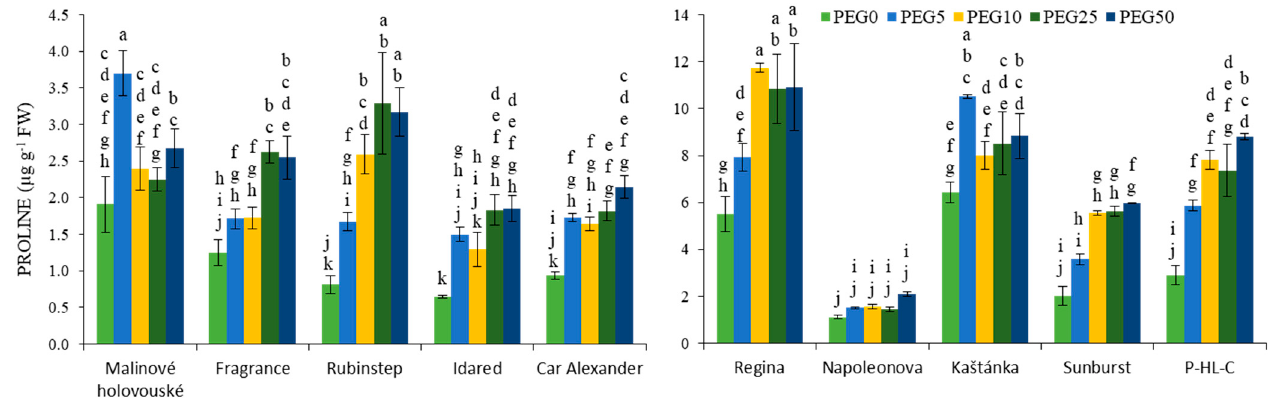
Figure 3. Effect of PEG-6000 concentration on proline content ( µ g g − 1 FW) for in vitro culture of apple ( left ) and cherry ( right ) cultivars. Error bars represent standard deviation (SD). Values within column, followed by the same letter(s), are not significantly different according to Tukey’s test ( p < 0.05).